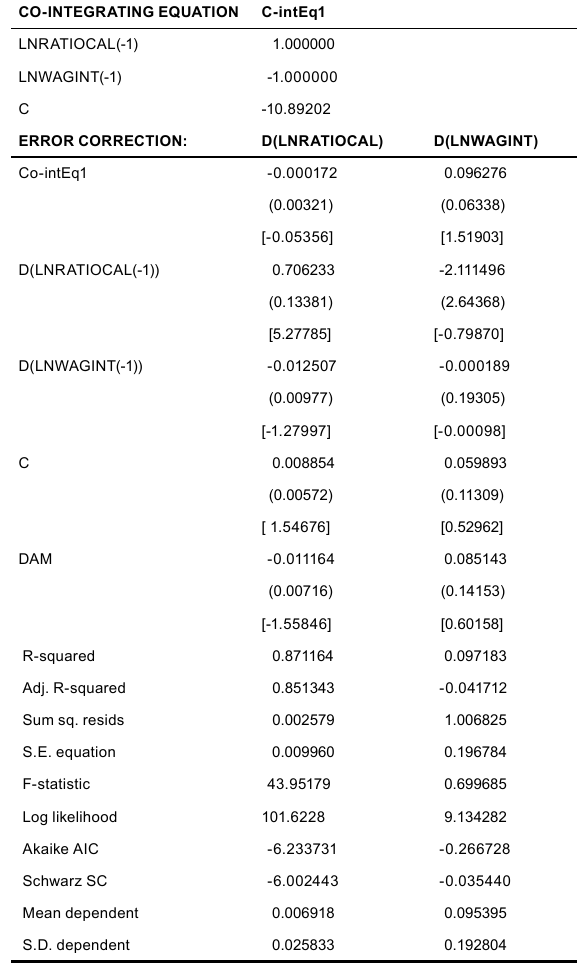
table 1 ARDL co-integration relationship between LNWAGINT and LNRATIOCAL